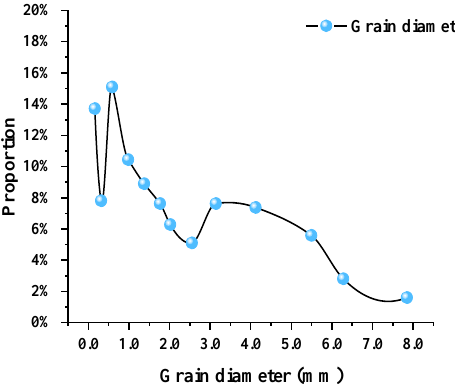
Figure 7. Enlarged size distribution of particles.